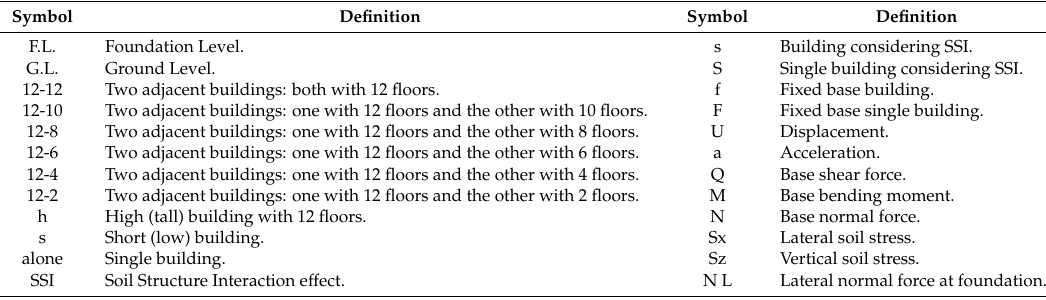
Table 2. Symbol definitions.